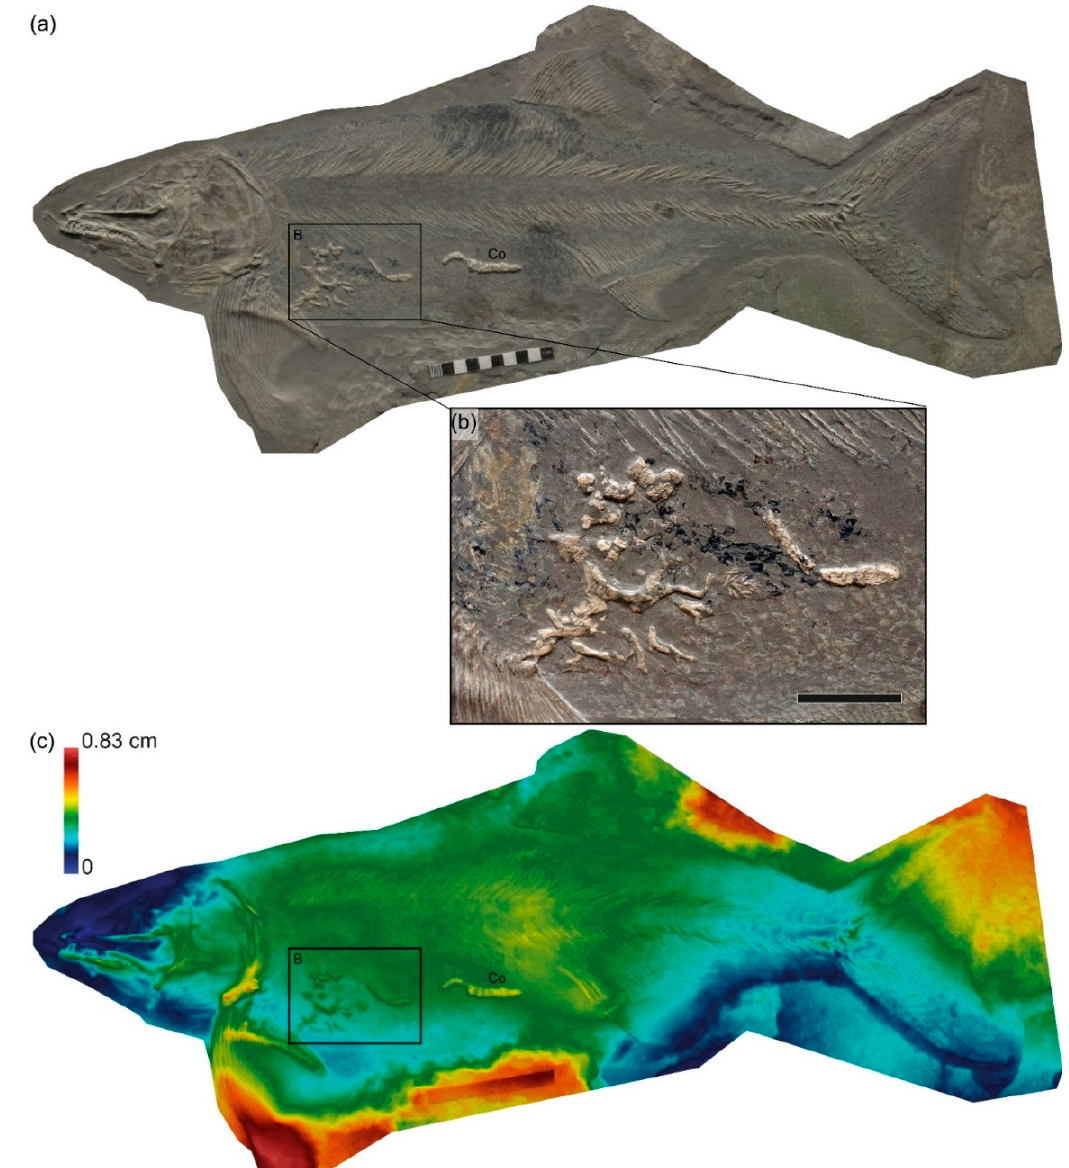
Figure 8. SMNS 51144, Saurostomus esocinus , prepared from below. ( a ) Orthophoto; ( b ) inset showing Chondrites burrows; ( c ) false-color depth map showing the topographical relationship between the carcass and the burrows. Warmer colors (reds) indicate deeper penetration of the bones into the sediment; cooler colors (blues) indicate elements closer to the sediment surface. Co = cololite. Scale bar in cm ( a ), 20 mm ( b ).